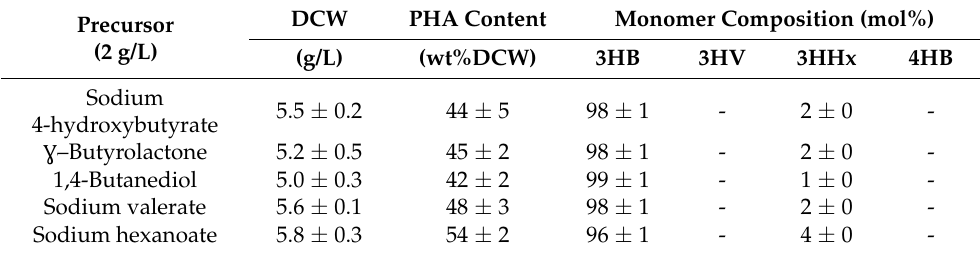
Table 3. PHA biosynthesis by C. necator PHB − 4/pBBR_CnPro- phaC Rp using different precursors in shake flask